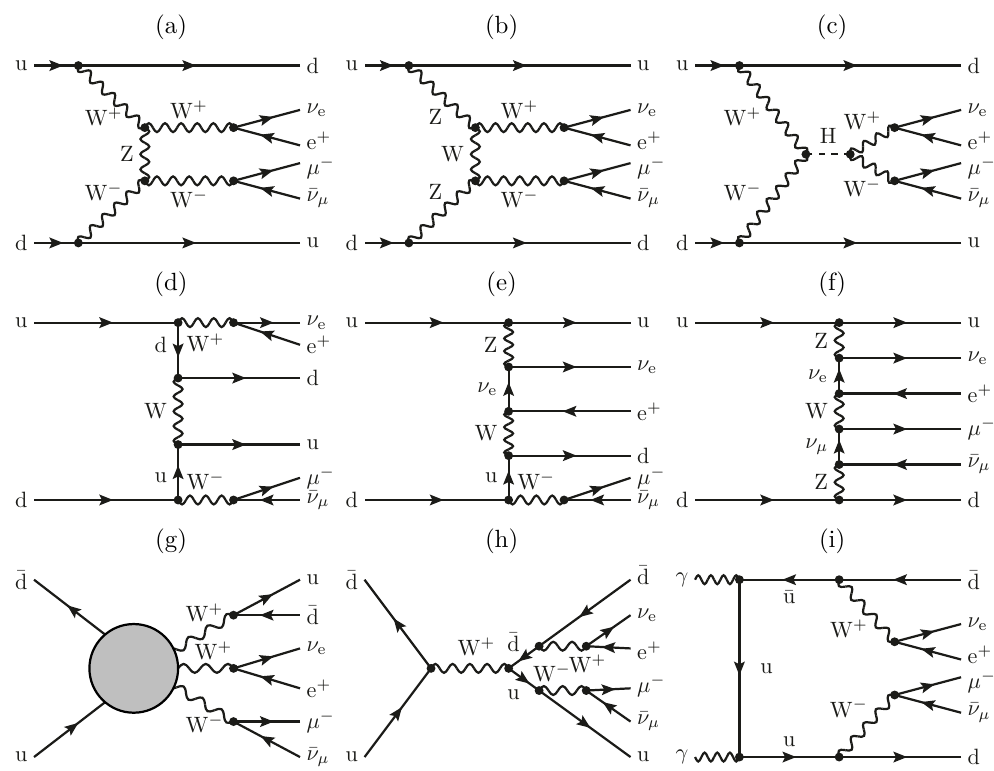
(cid:0) (cid:1) g 6 . The first row (a) – (c) shows signal diagrams O